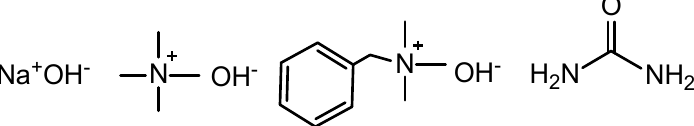
Figure1. ThestructureofNaOH,tetramethylammoniumhydroxide(TMAH),benzyltrimethylammonium hydroxide (Triton B), and